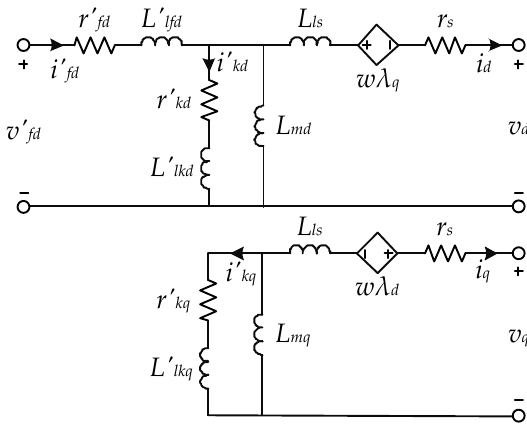
Figure 3. Equivalent circuit of the main generator.